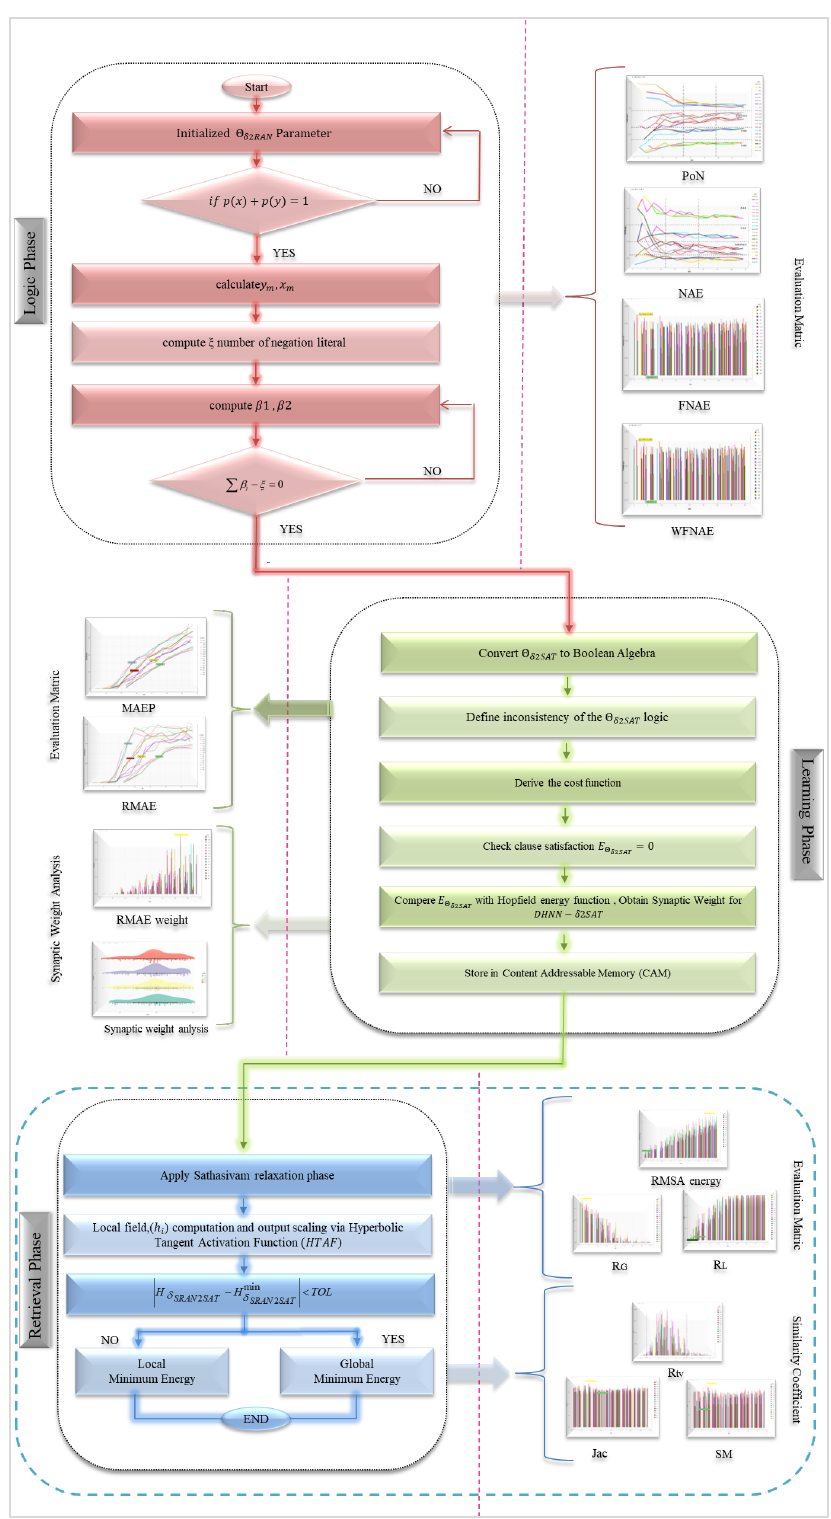
Figure 3. Flowchart of 2 DHNN SAT − and Experimental evaluation.